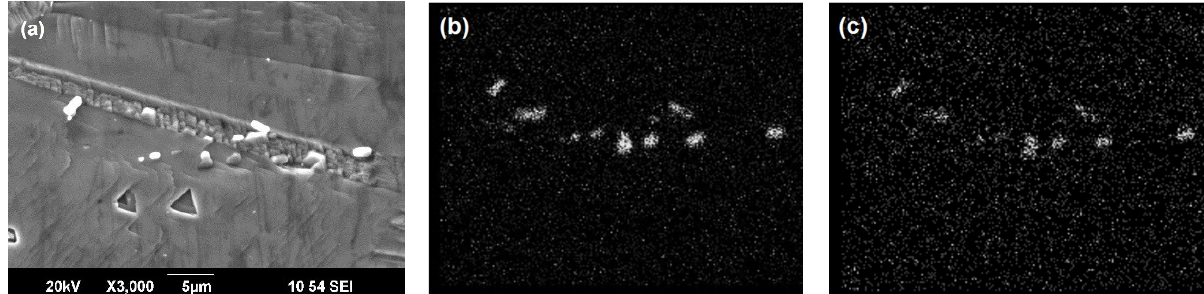
Figure 2: Alloy of the Cu-Cr-Cd-Zr system after homogenization annealing (1050 ∘ C) with quenching: a–structure (SEM), b–Cr distribution pattern; c–Zr distribution pattern.